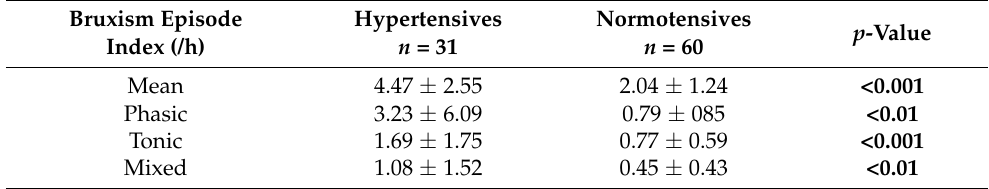
Table 3. Bruxism episode index in the study group and control group.